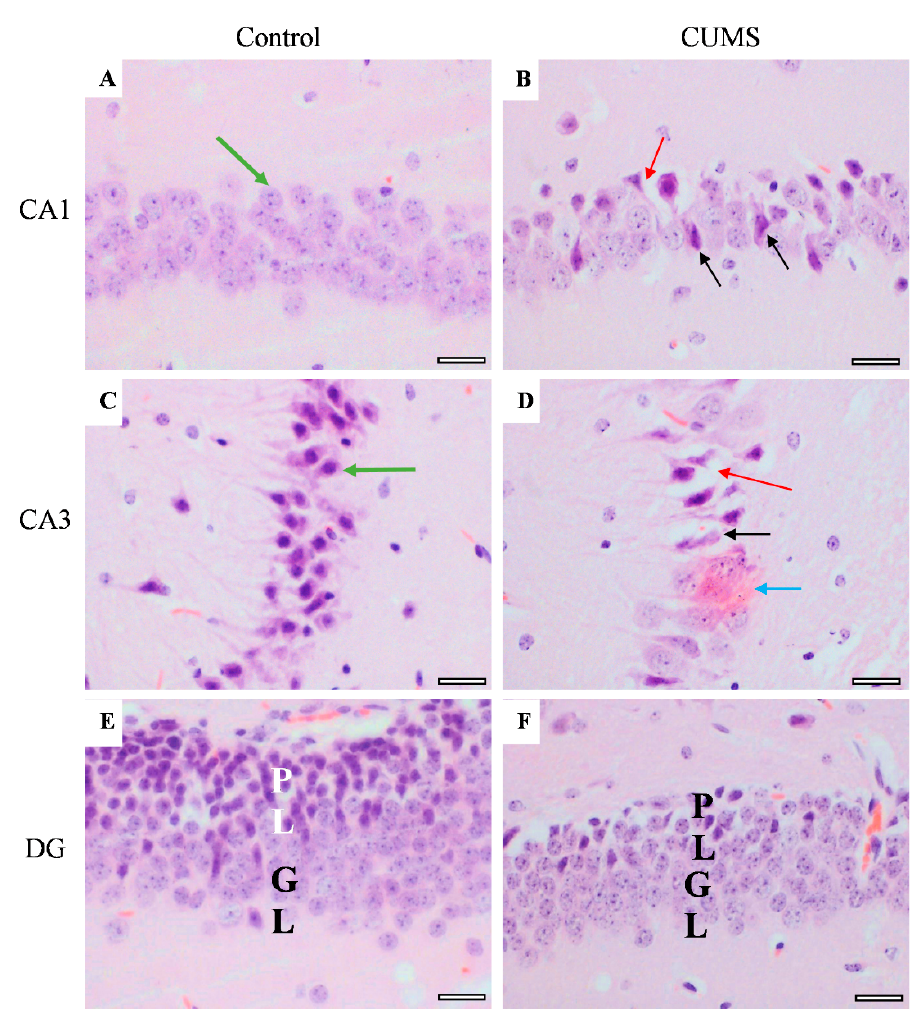
Figure 10. The effect of CUMS on the hippocampal regions. Representative images of hippocampus areas (CA1 and CA3) and dentate gyrus (DG) from control ( A , C , E ) and CUMS ( B , D , F ). The controls had normal neurons with vesicular pale nuclei in CA1 (green arrow) ( A ) while the control CA3 showed normal large basophilic neurons with dark vesicular nuclei and clear axons (green arrow) ( C ). However, both CA1 and CA3 in CUMS ( B , D , respectively) had degenerated neurons (black arrow) and loss of tissue surrounding the degenerated neurons (red arrow). A dark eosinophilic plaque (blue arrow) was observed in CUMS CA3 ( D ). The dentate gyrus (DG) polymorphic layer (PL) is thinner in CUMS ( E ) compared with controls ( F ). There was no significant change in the DG granular layer (GL) in both groups. Scale bar = 20 µm.